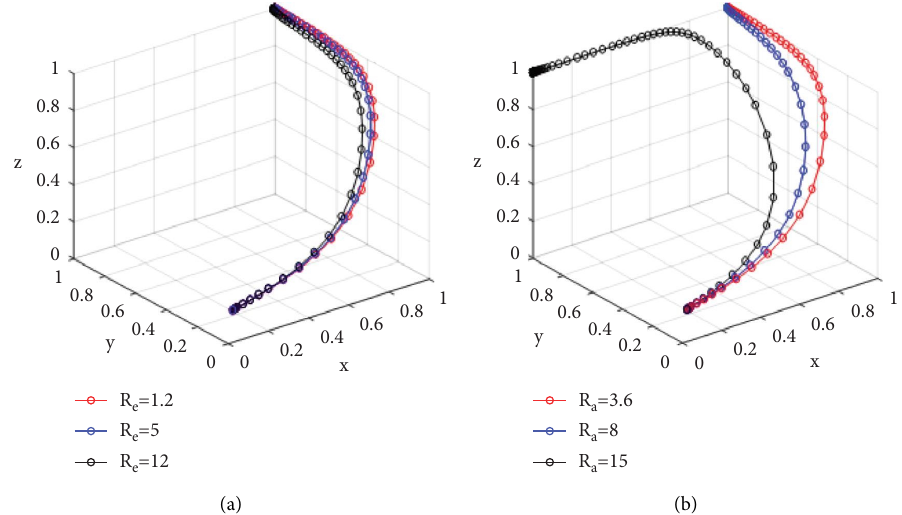
Figure 1: Efect of government subsidies on evolution results. (a) R e refers to the subsidies received by mariculturists on the results of system evolution; (b) R a refers to the subsidies obtained by aquatic enterprises.